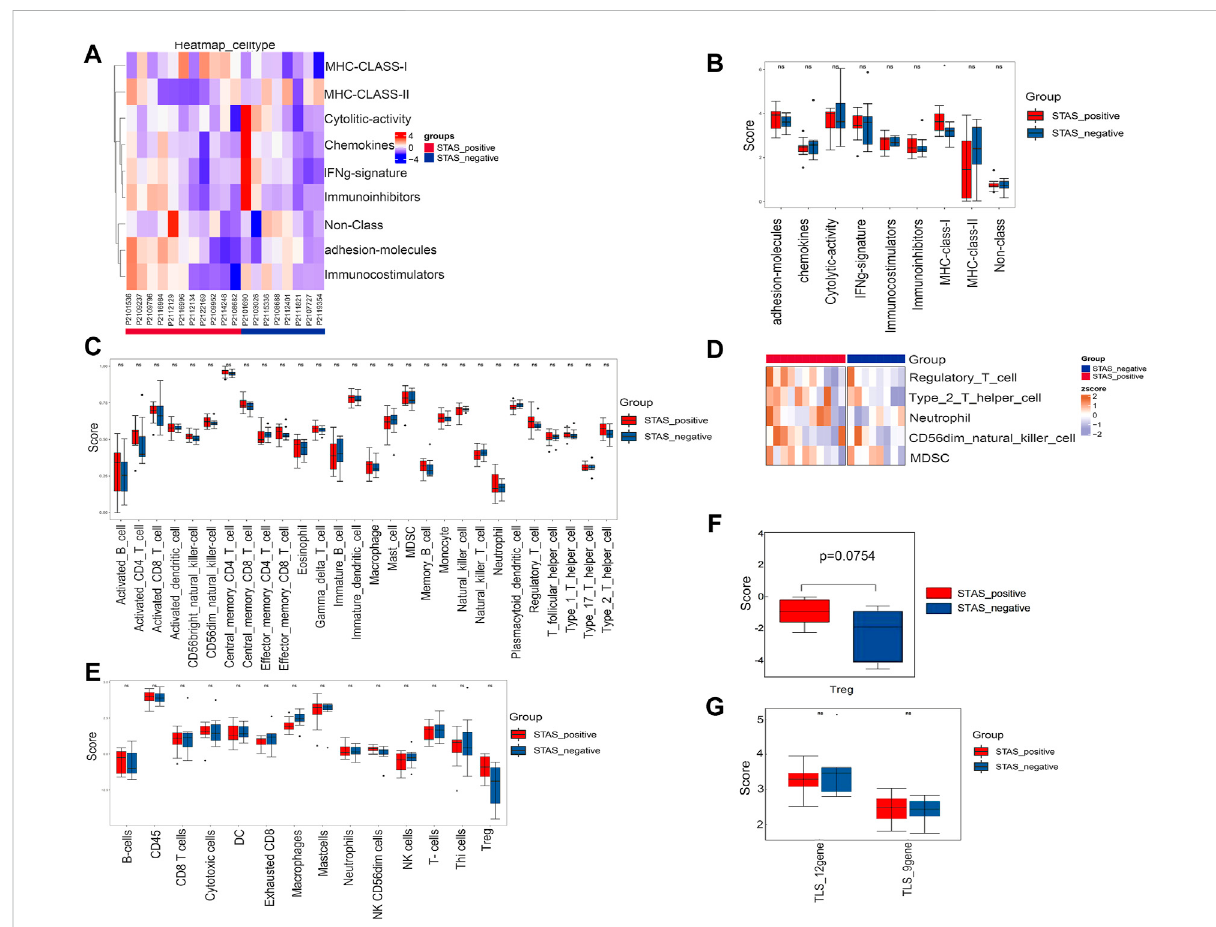
FIGURE 7 Analysis of related factors of immune microenvironment between STAS_positive and STAS_negative groups. (A) Heat map of immunoactivity analysis. (B) Boxplotofimmunoactivityanalysis. (C) Boxplotofproportionsof28types ofimmunecells. (D) Heatmapshowingcomparativeanalysis among fi ve cell subsets. (E) Box plot of the abundance of 14 immune cell populations. (F) Box plot of Treg. (G) Box plot of comparison of TLS. * p < 0.05.